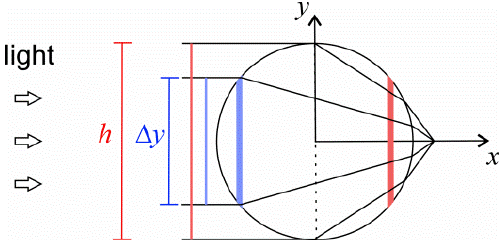
Figure 5. Qualitative scheme of light propagation in a crystal of round cross section.